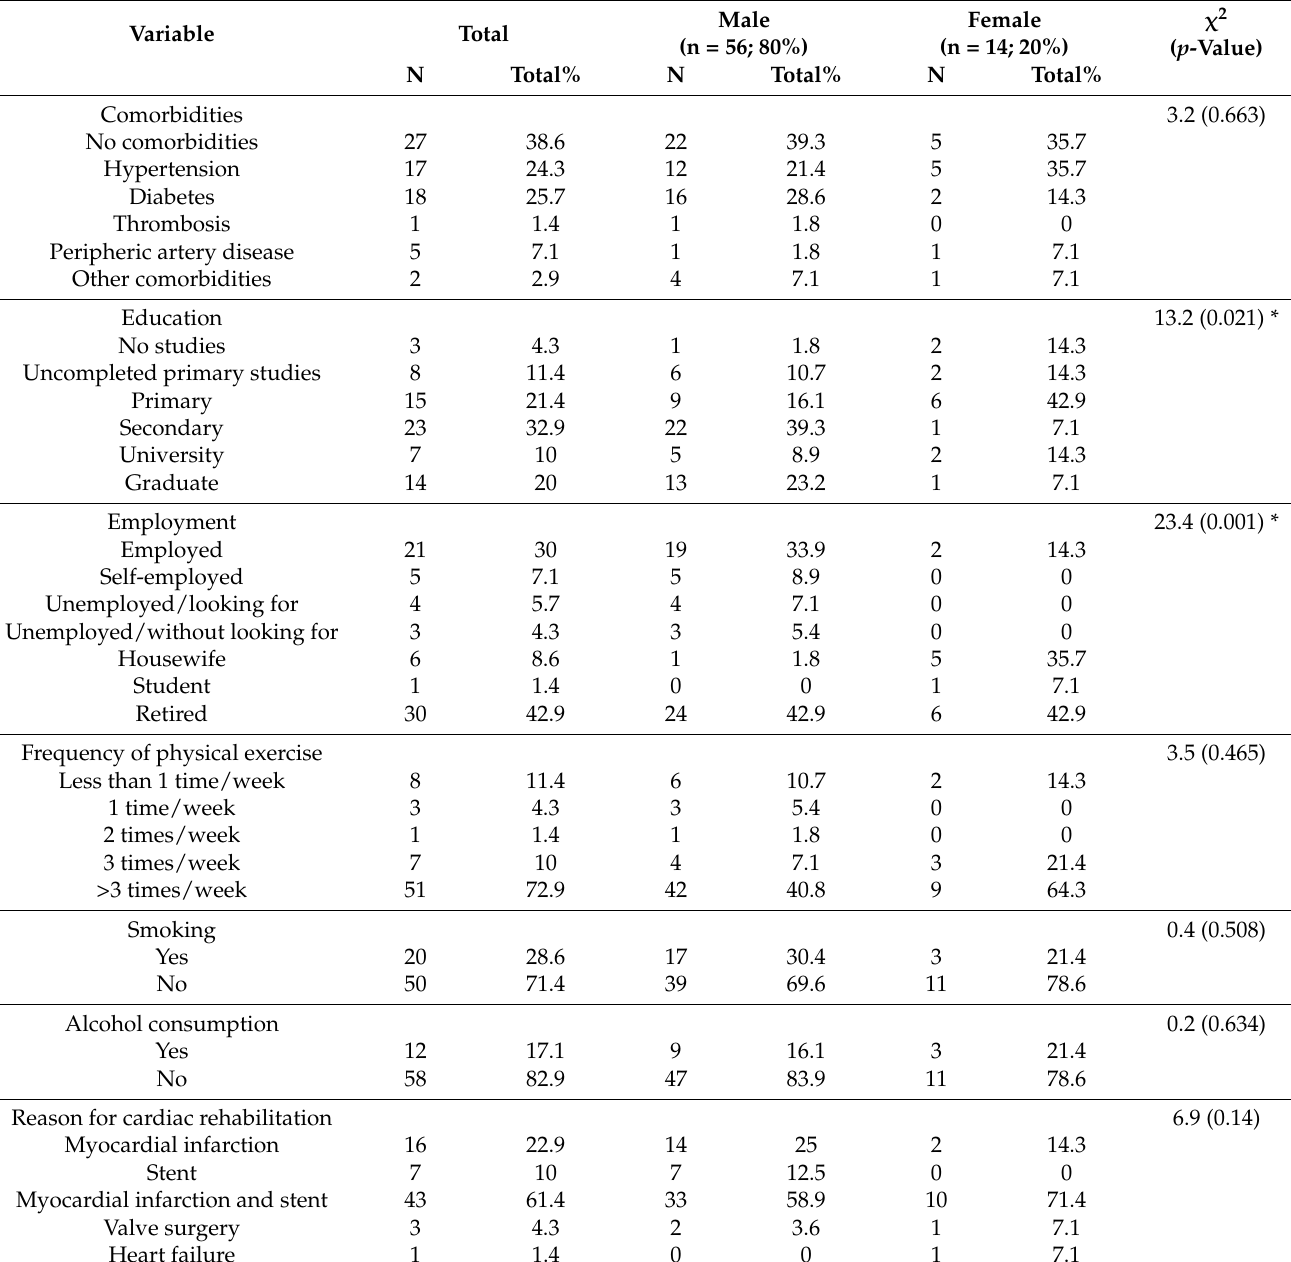
Table 1. Sociodemographic characteristics of the